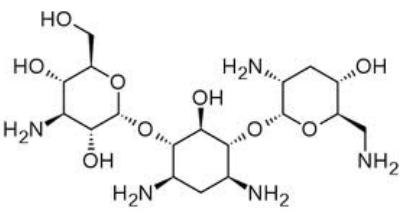
Figure 2. Chemical structure of the tobramycin